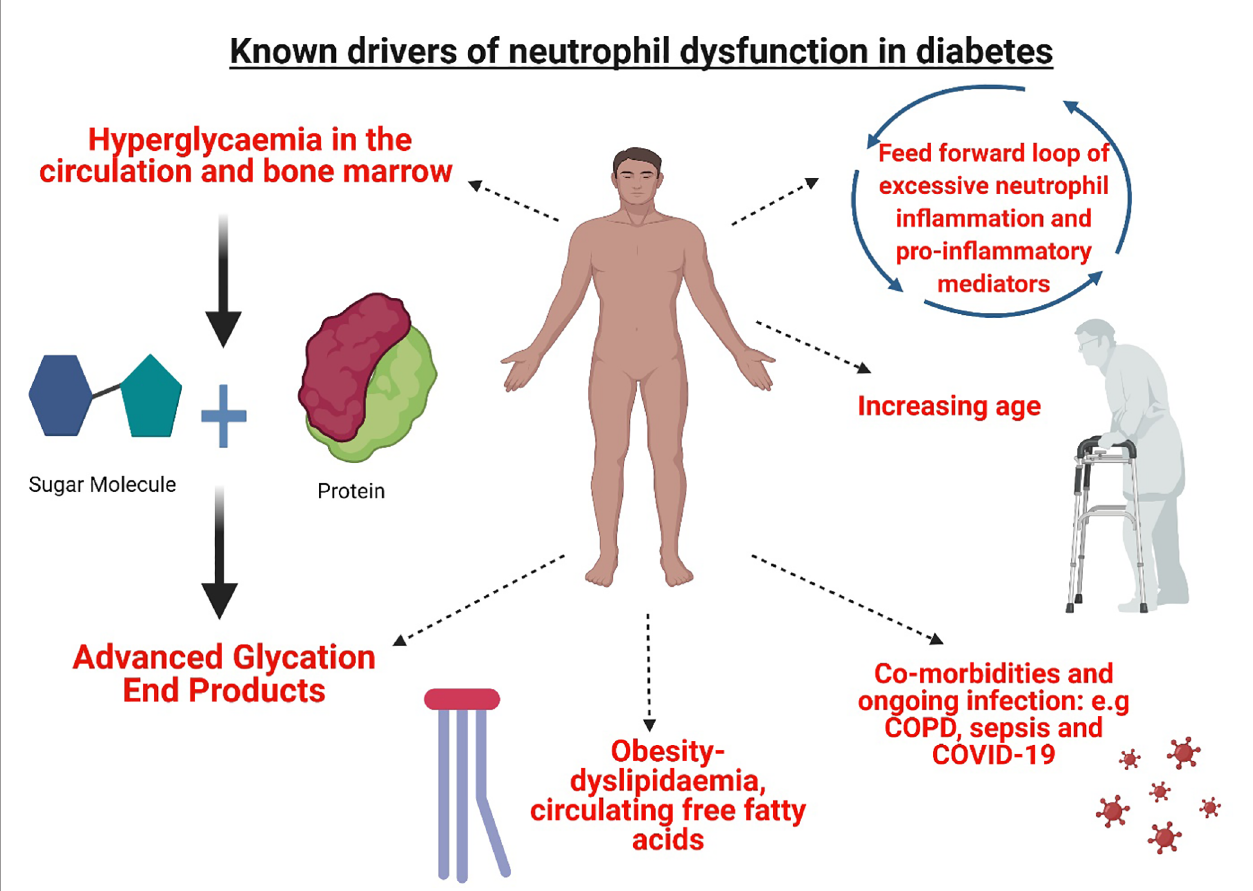
FIGURE 1 | Mediators of neutrophil dysfunction present in T1D and T2D. The microenvironment of T1D and T2D presents a complex interplay of mediators of neutrophil dysfunction. Hyperglycaemia and the formation of advanced glycation end products in the circulation and the bone marrow modify circulating neutrophils and myeloid precursors. Metabolic perturbations in lipid metabolism and increased synthesis of circulating free fatty acids further contribute to aberrant dysfunction. Resulting activated neutrophils produce pro-in fl ammatory mediators adding to a cycle of in fl ammation. Increased age further impacts neutrophil function, in addition to co-morbidities and infection, where altered neutrophil functions are previously shown e.g chronic obstructive pulmonary disease (COPD) sepsis and COVID-19. Figure created with